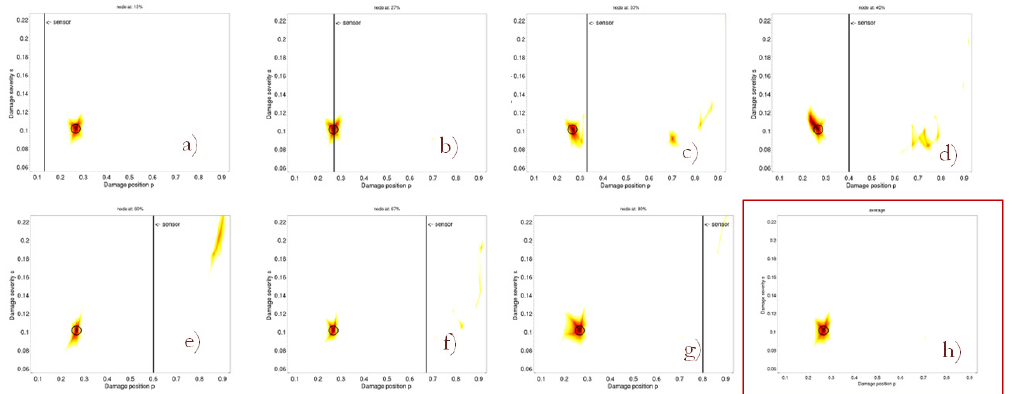
Figure 7: Nonlinear harmonic identification on a simply supported beam with damage p = 0.27, s = 0.1 excited at l F / l =0.06. a)-g)